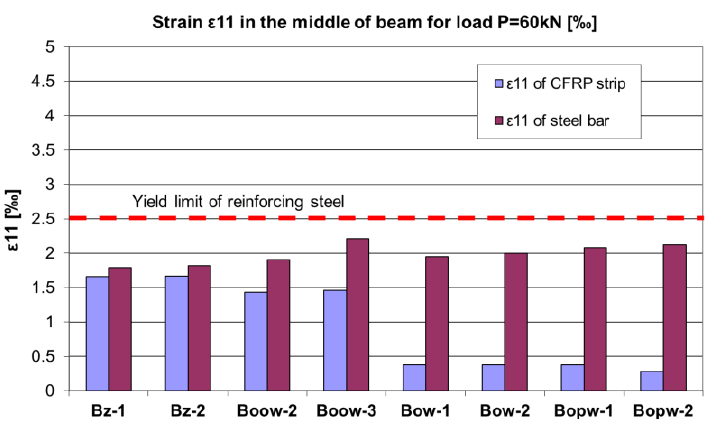
Figure 6. Steel strains of middle reinforcing bar and composite strip in the middle of beam span for a load of P = 60 kN.